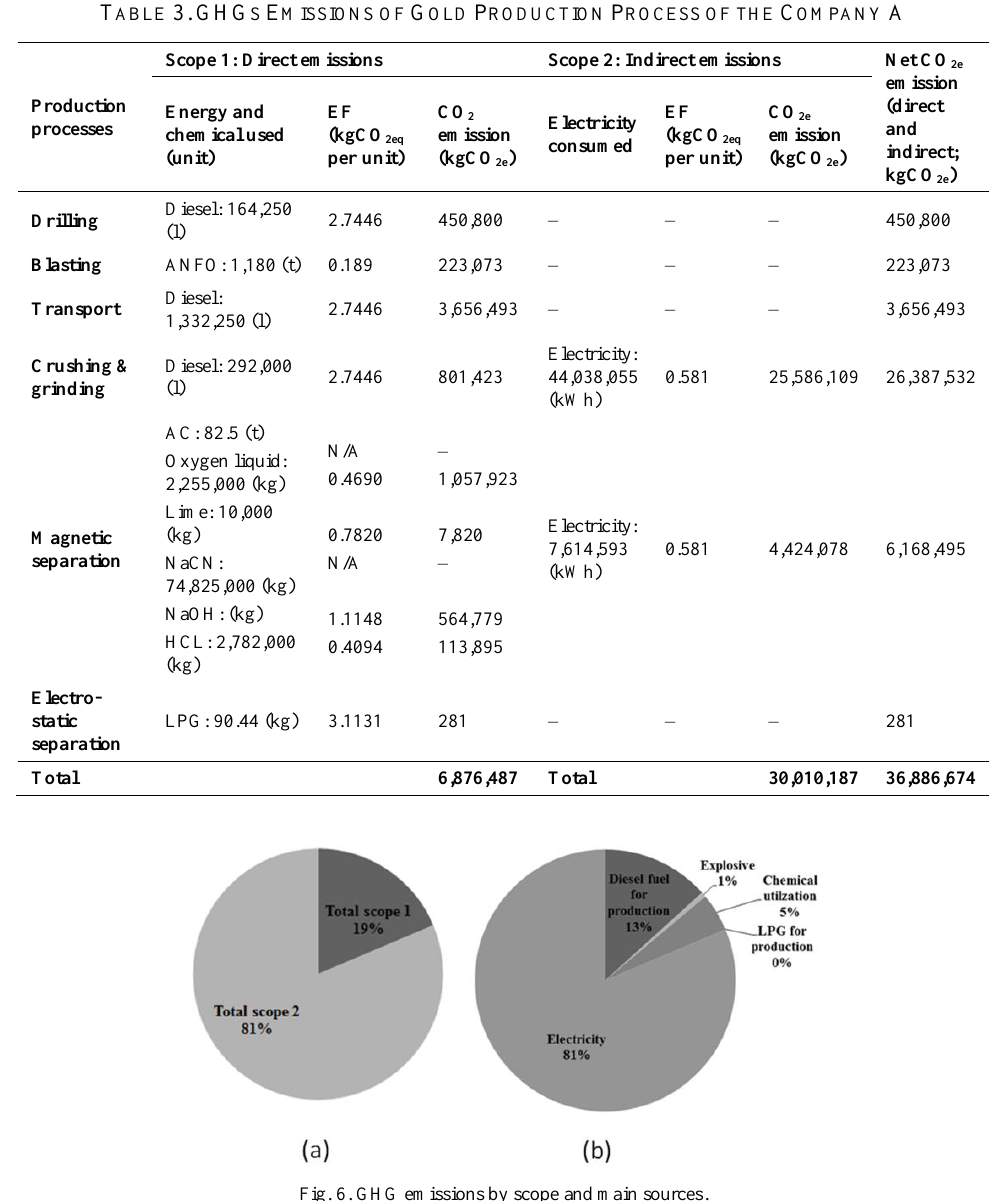
Fig. 6. GHG emissions by scope and main